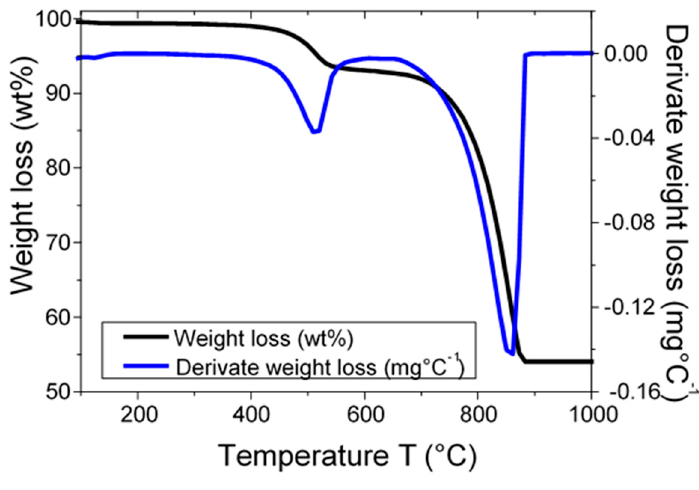
Figure 3. TG (thermogravimetry) and DTG (derivative thermogravimetry) curves of limestone/clay (LS/C) mixtures.